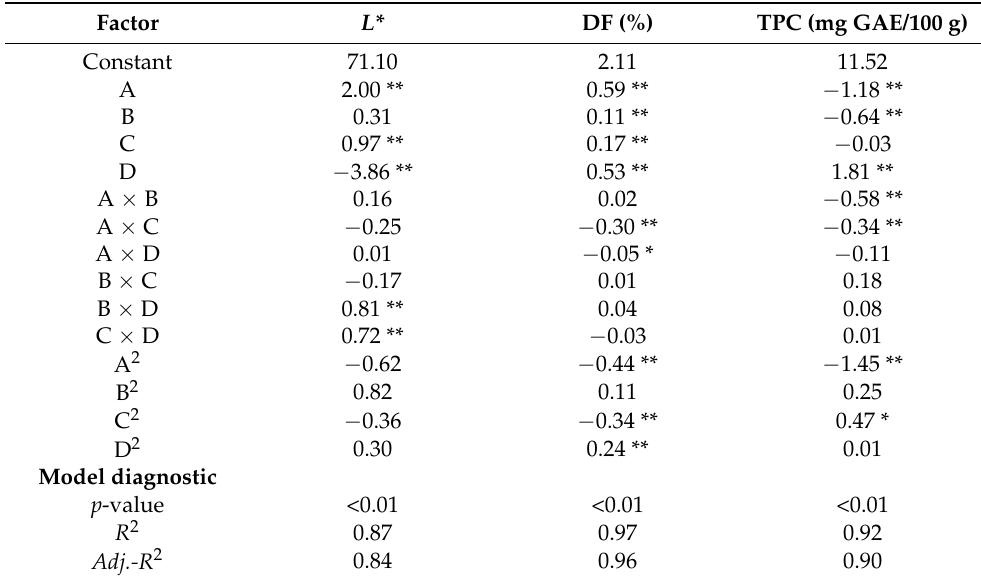
Table 3. ANOVA results for quadratic model fitted to dry pasta parameters.